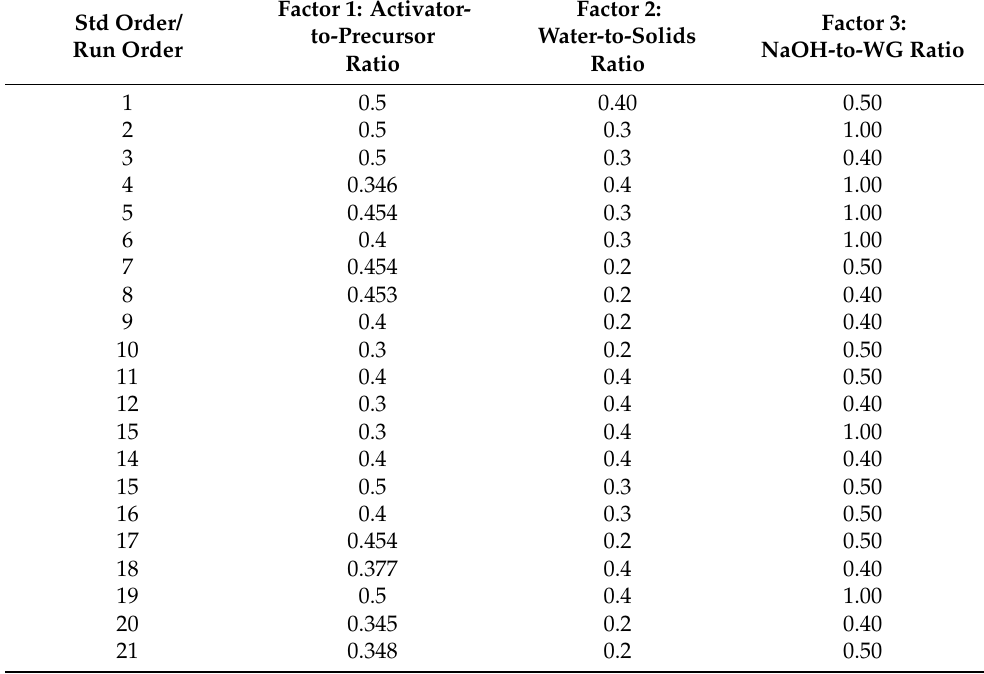
Table 6. Experiment design (21